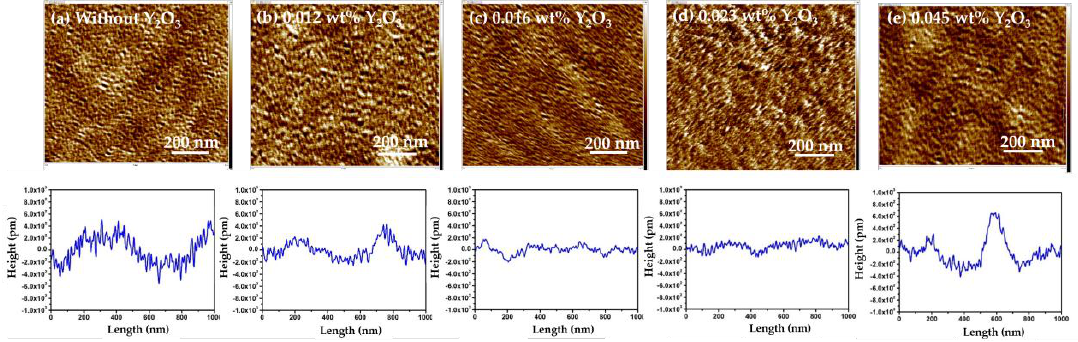
Figure 4. AFM morphology and profile depth of the pinholes in the surface of the Y 2 O 3 /chitosan thin film with various Y 2 O 3 concentrations: ( a ) Without Y 2 O 3 ; ( b ) 0.012 wt %; ( c ) 0.016 wt %; ( d ) 0.023 wt %; and ( e ) 0.045 wt %.